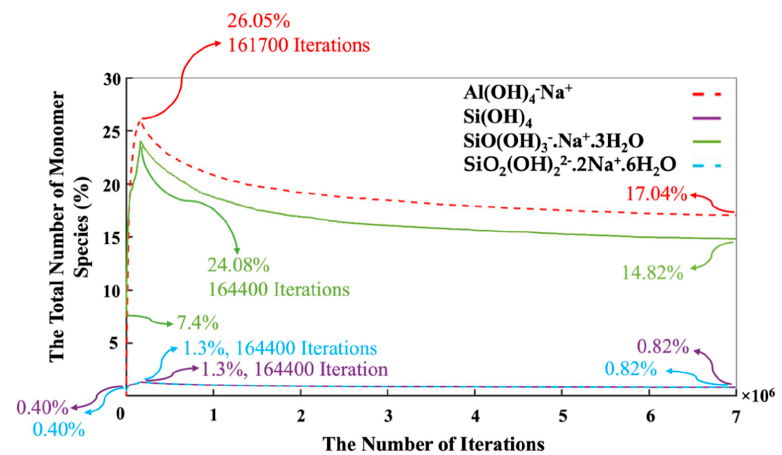
Figure 7. The evolution of the number of monomers (three silicates and one aluminate species type) present in the system during 7 million iterations. Metakaolinite particles were not considered at the beginning of the simulation (at zero iteration), as they were along the dissolution process.